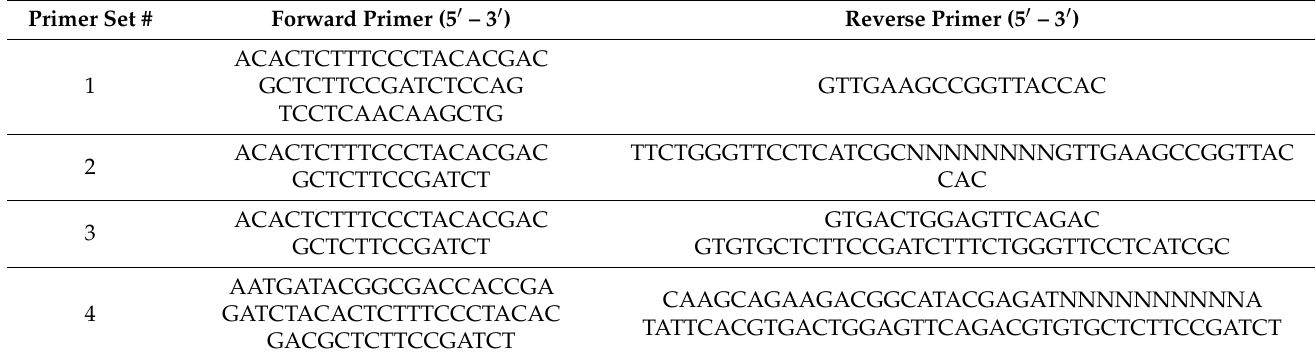
Table 5. Primer sequences used in overhang PCR for appending trap tag and sequencing adapters. Primer Set